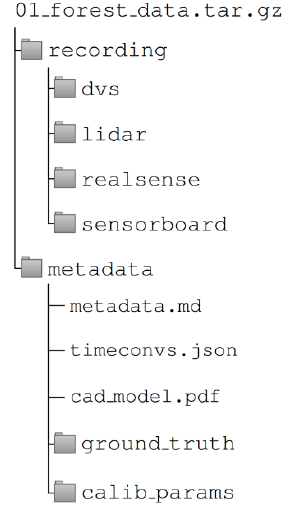
Fig. 6. Publish ready file structure tree of the main data